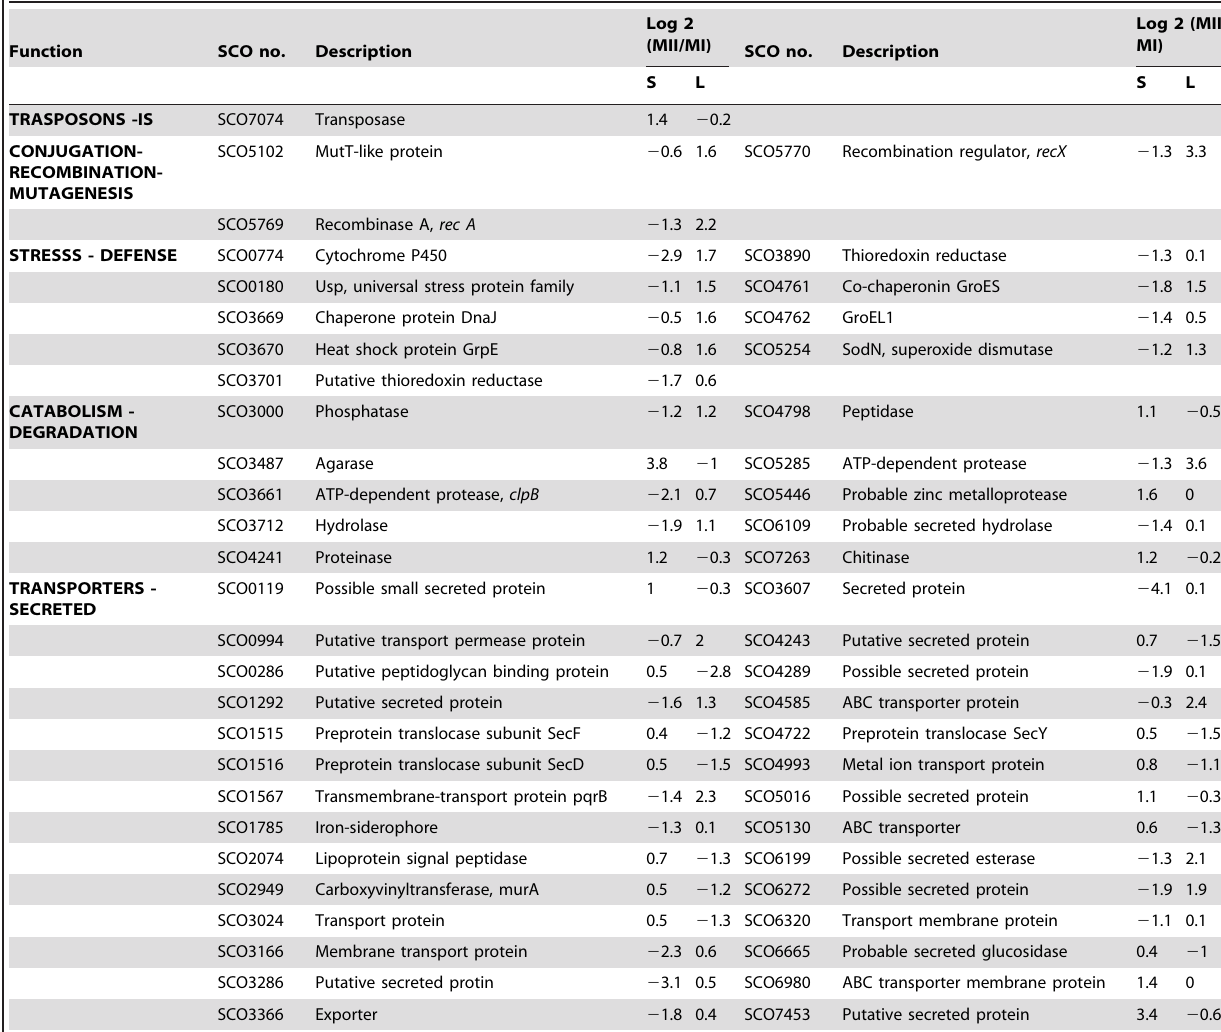
Average log2 abundance values from three biological replicates of the MII with respect to MI in solid (S) and liquid (L) cultures. Only transcripts with significant abundances are shown (log2 abundance greater than 6 1 in liquid and/or solid cultures). Functions (according to Gene bank, Gene Ontology, Conserved Domain, and KEGG and StrepDB databases): Primary metabolism (DNA/RNA replication, aerobic and anaerobic energy production, glycolysis and glyconeogenesis, pentose phosphate pathway, amino acid metabolism, nucleotide metabolism, translation, protein folding, RNA/protein processing, nucleases/RM methylases); secondary metabolism (secondary metabolites synthesis); differentiation (TTA bldA targets, Bld and Whi proteins); regulatory genes (transcriptional regulators, kinases, other regulatory genes); transposons - insertion sequences; conjugation – recombination - mutagenesis; stress and defense proteins; catabolism - degradation; lipid metabolism; transporters and secreted (ABC transporters, transporters and secreted proteins). Genes with ‘‘unknown’’ functions (Table S1) were not included.